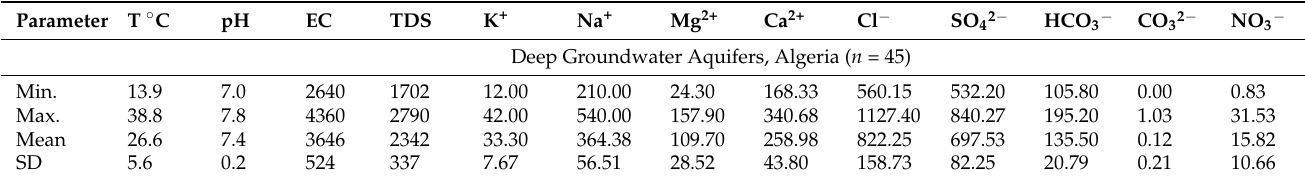
Table 3. Statistical analysis of the physical and chemical variables of the groundwater in the CT